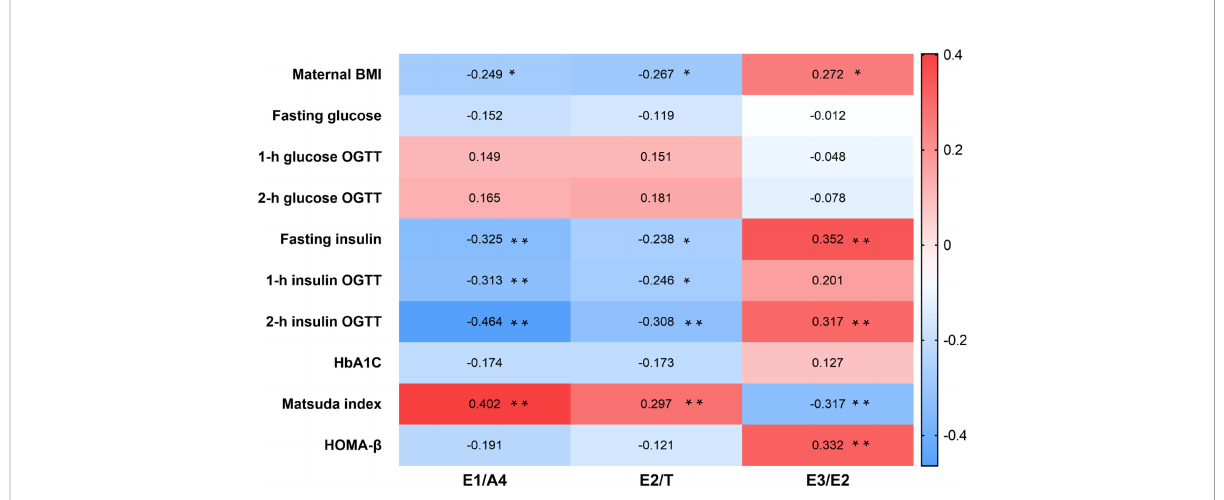
FIGURE 2 Heatmap of steroid hormones ratio and clinical characteristics in GDM patients. Correlation between steroid hormone ratio and clinical data in women with GDM using Spearman correlation analysis. * p < 0.05, ** p < 0.01. GDM, gestational diabetes